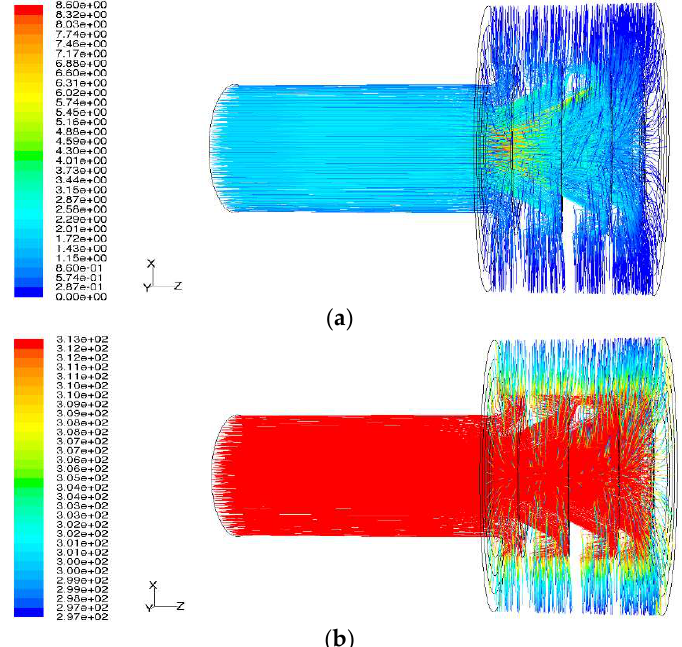
Figure 10. The current line fields inside the cylindrical box with baffles and three layers for the first version (temperature of 313 K = 40 °C): ( a )—velocity (m/s); ( b )—temperature (K) [32].